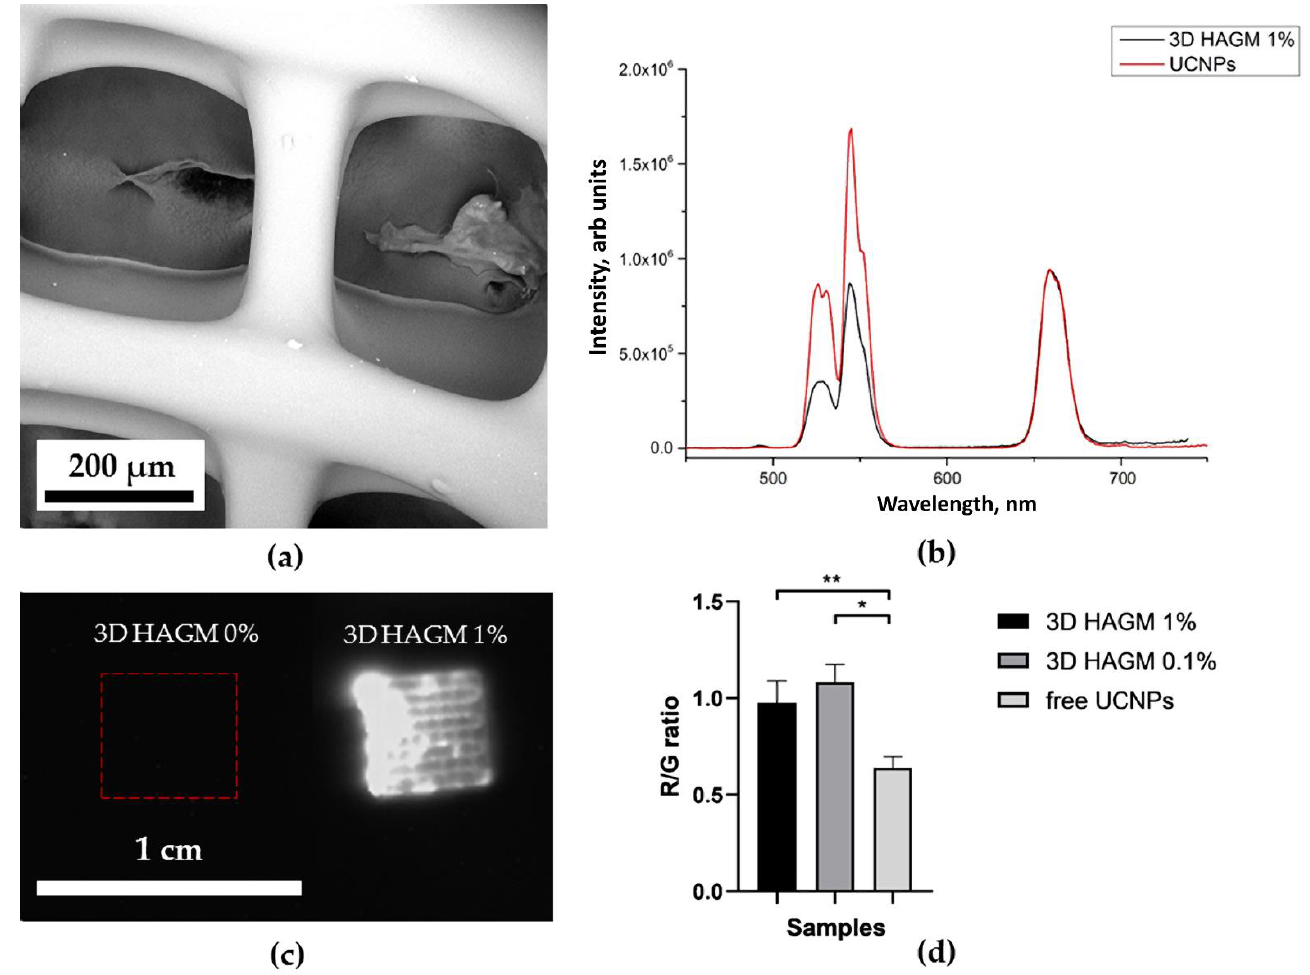
Figure 9. SEM image of 3D-printed HAGM scaffolds ( a ); normalized photoluminescence spectra of the UCNPs and the UCNPs in- cluded in 3D HAGM scaffolds ( b ); photograph of 3D HAGM scaffolds with 0 and 1 mg of UCNPs per 100 mg of polymer at 976 nm ( c ). Ratio of the intensity of the red peak at 658 nm to the intensity of the green at a wavelength of 544 nm of UCNPs and 3D HAGM scaffolds (0.1 and 1% UCNPs) * p < 0.05, ** p < 0.01 in Student ’ s t-test ( d